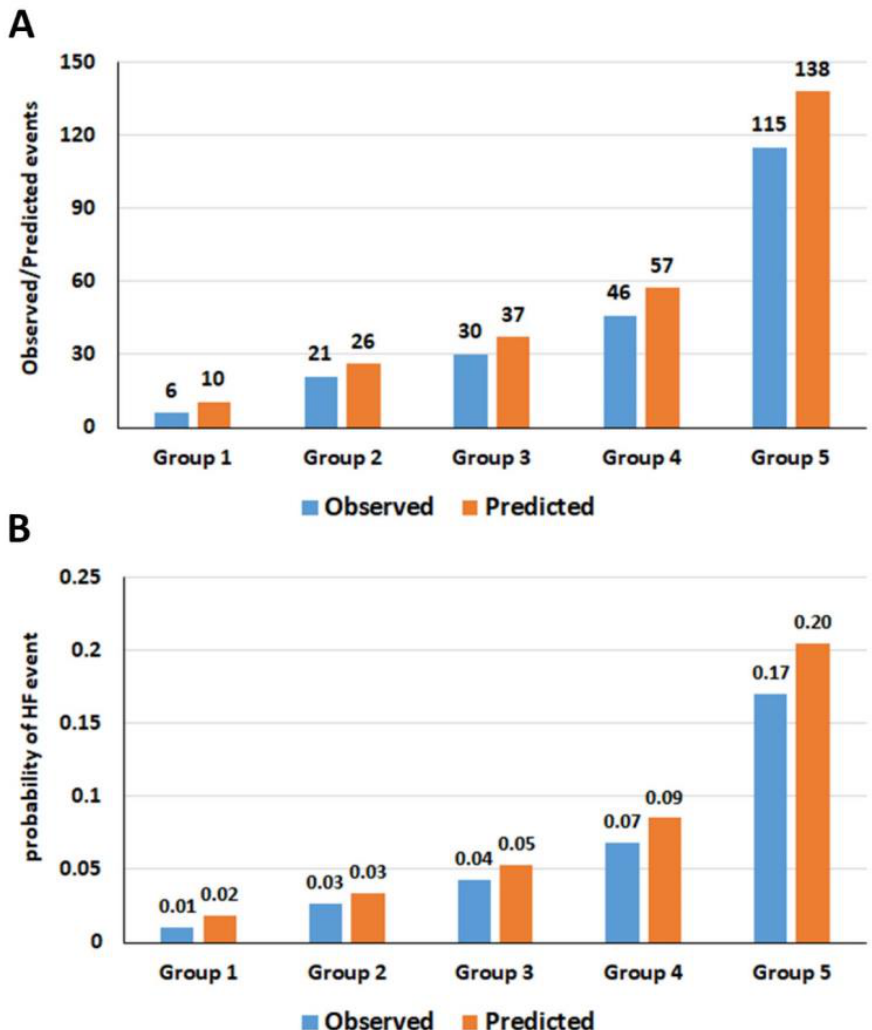
Figure 2. Bar graph showing agreement of observed and predicted HF events ( A ) and probability of HF events ( B